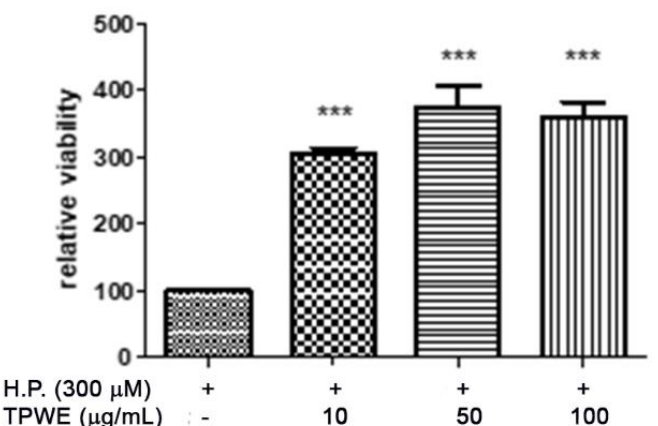
Figure 8. The stimulating effect induced by the Tanacetum parthenium water extract (TPWE: 10–100 µ g/mL) on the viability of HypoE22 cells exposed to 300 µ M of hydrogen peroxide (H.P.). The cell viability was evaluated using an MTT test. ANOVA, p < 0.0001, *** p < 0.001 vs. the H.P. group.